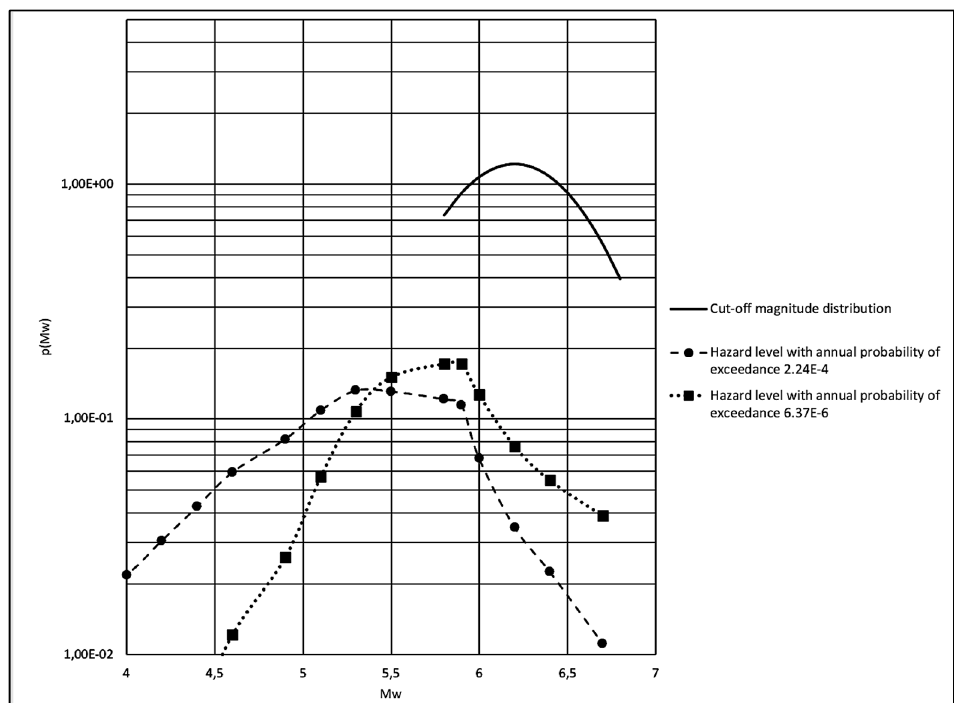
Figure 1. Deaggregation matrix for 12,642 years return period [28].